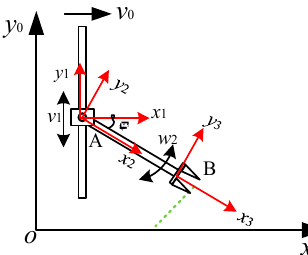
Figure 3. Mathematical model of transplanting robot arm.